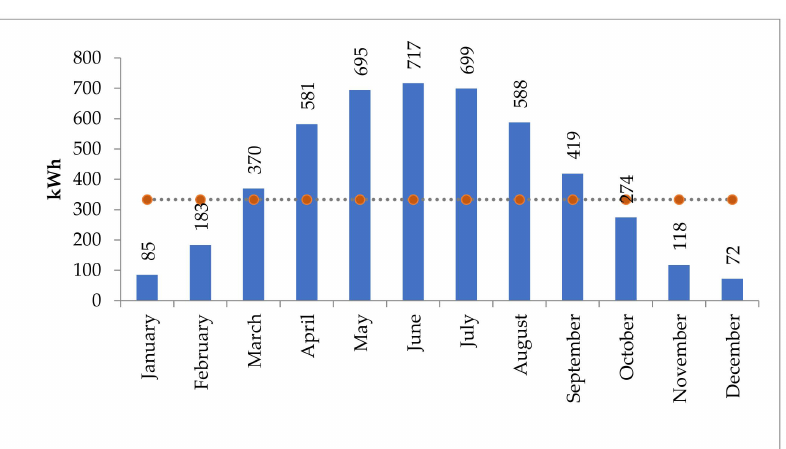
Figure 7. Expected cumulative electricity production from a photovoltaic system located on the roof of a planned single-family building in Turawa-Marszalki, kWh.